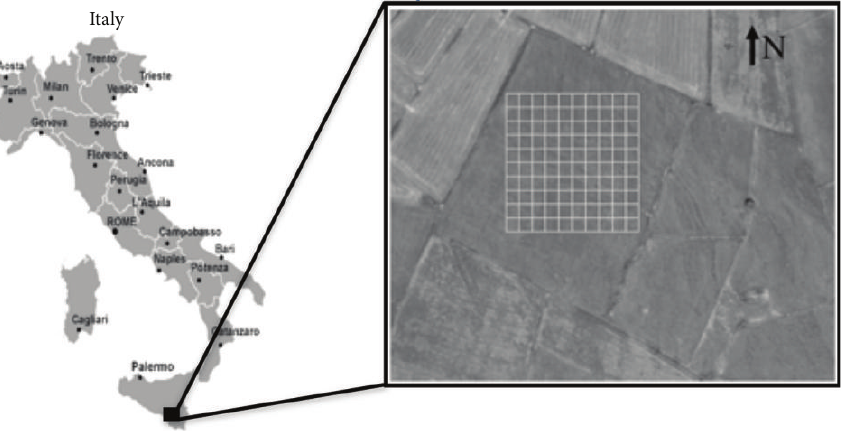
Figure 11: Case study site and positioning